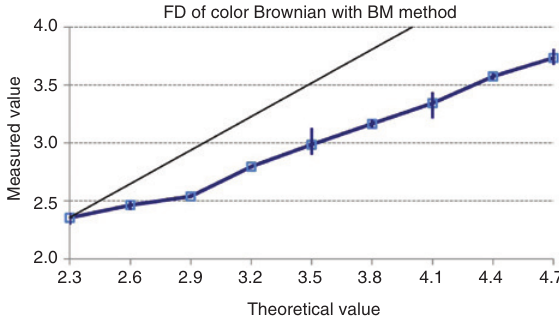
Figure 6: Measurements of color FBS with box merge.